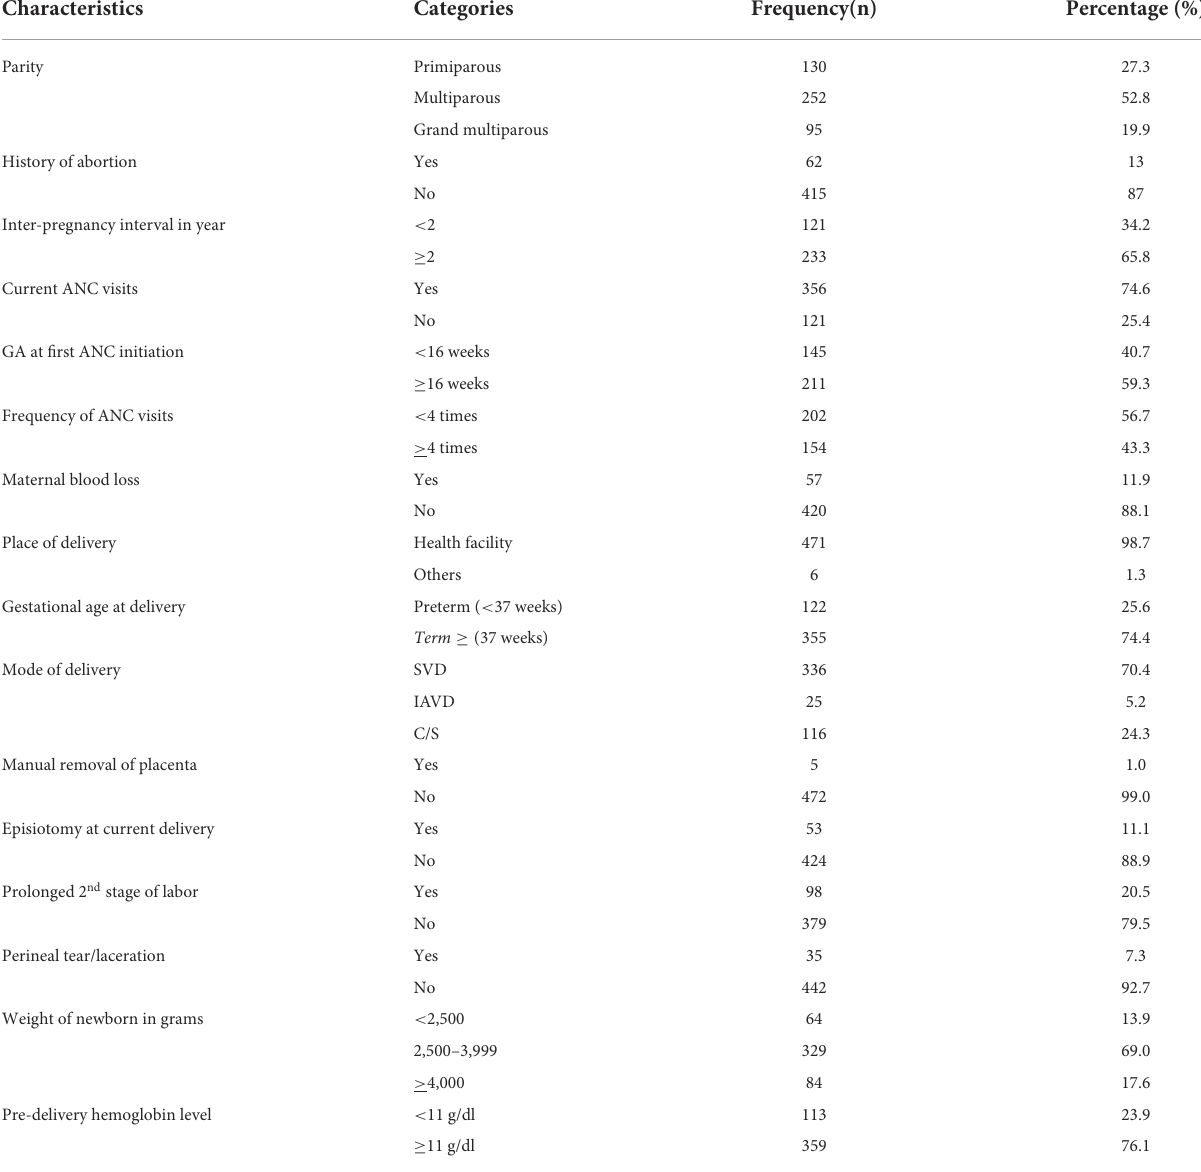
TABLE 2 Obstetrics-related factors of postpartum women admitted to the maternity ward in the public hospitals in Harari regional state, Eastern Ethiopia, 2021.